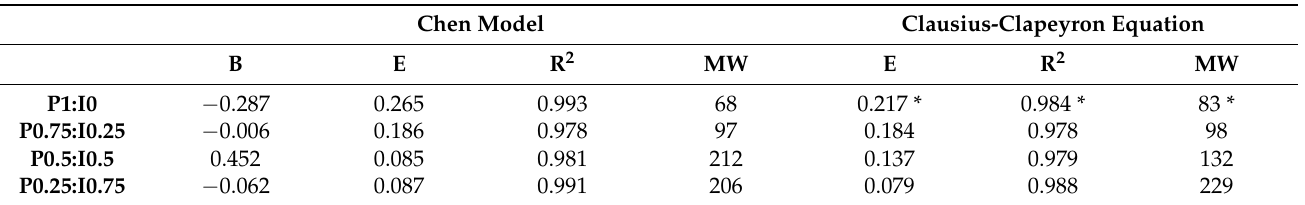
Table 3. Constants of the Clausius –Clapeyron equation and Chen model fitted to the experimental data of the pumpkin–inulin